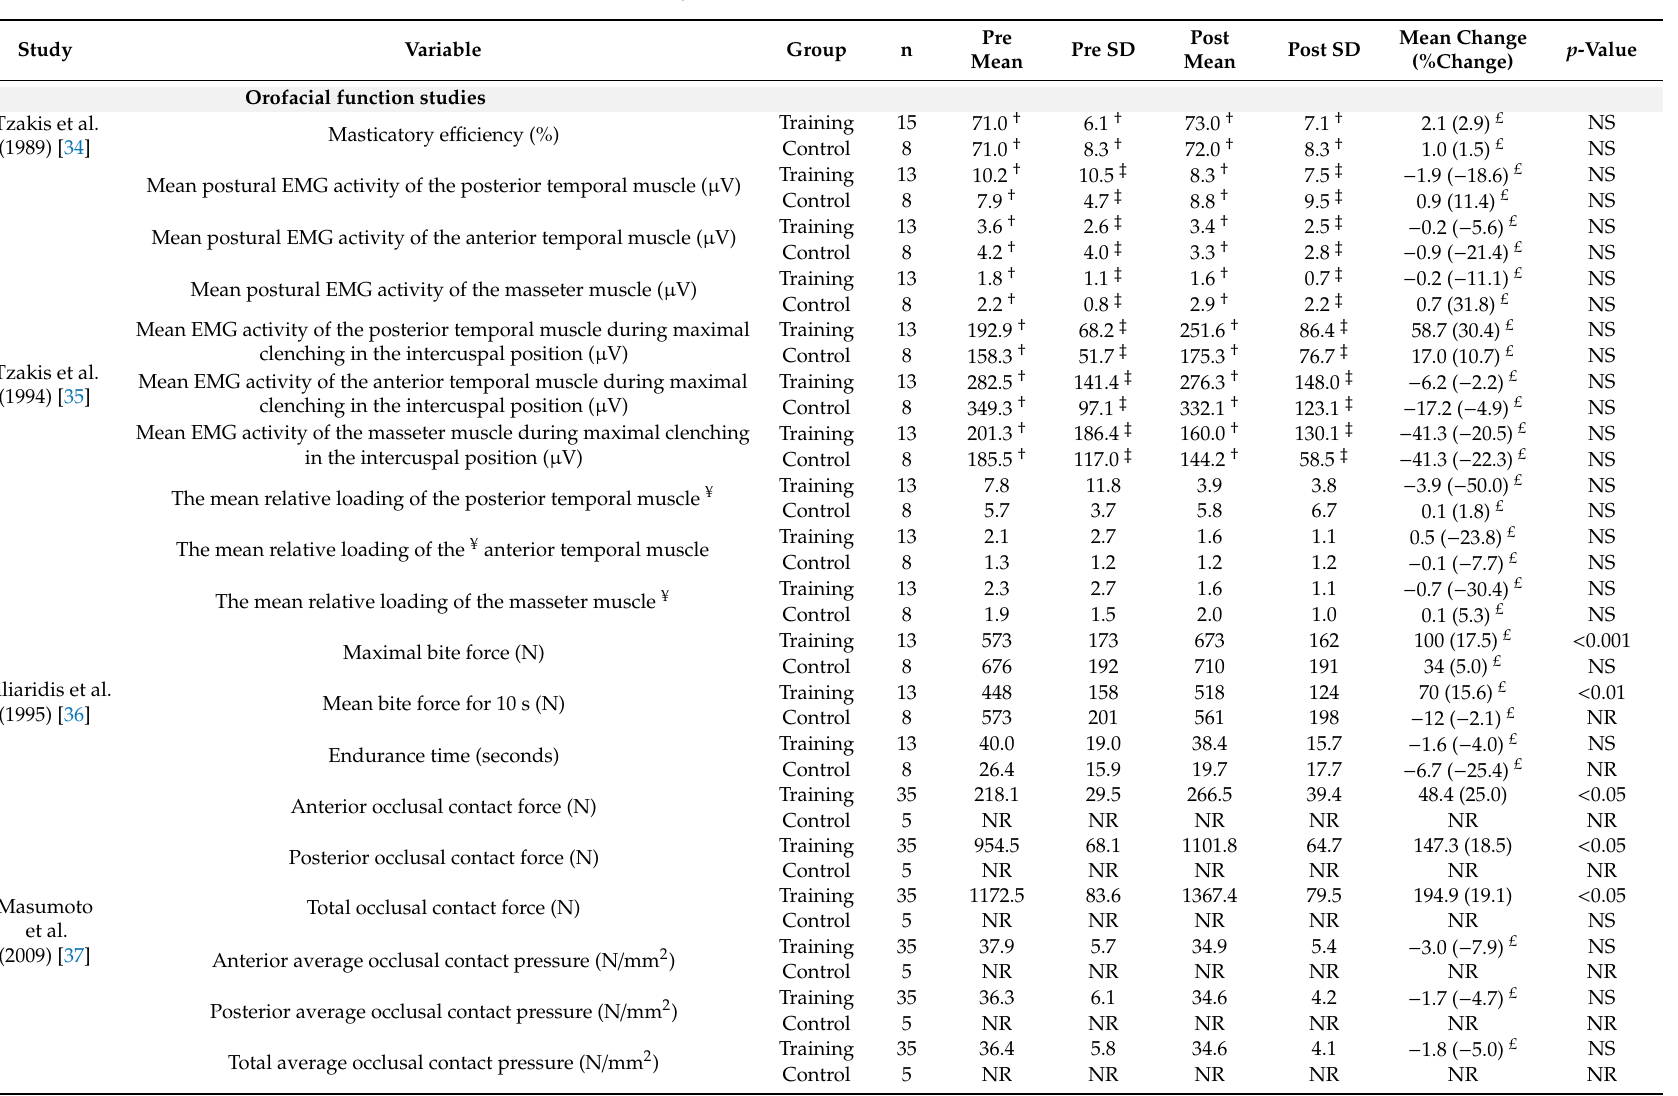
Table 3. Summary of the main results of the included